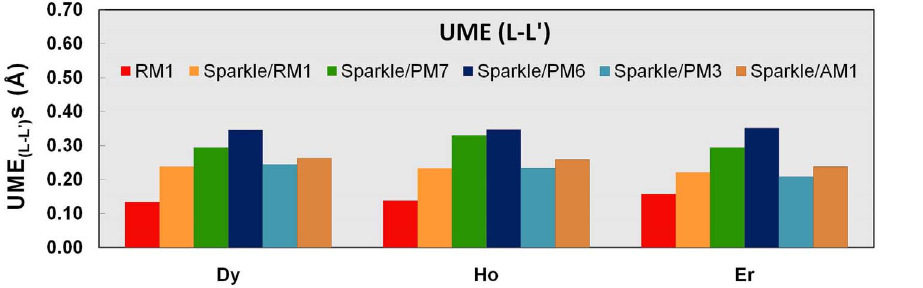
Figure 8. UME (L-L 9 ) s obtained using the RM1 model for the lanthanides and all five versions of the Sparkle Model: Sparkle/RM1, Sparkle/PM7, Sparkle/PM6, Sparkle/PM3 and Sparkle/AM1 for all complexes of the universe set for each of the lanthanide trications: Dy(III), Ho(III) and Er(III). The UMEs are calculated as the absolute value of the difference between the experimental and calculated interatomic distances between the coordinated atoms, L-L 9 , summed up for all complexes, for each of the